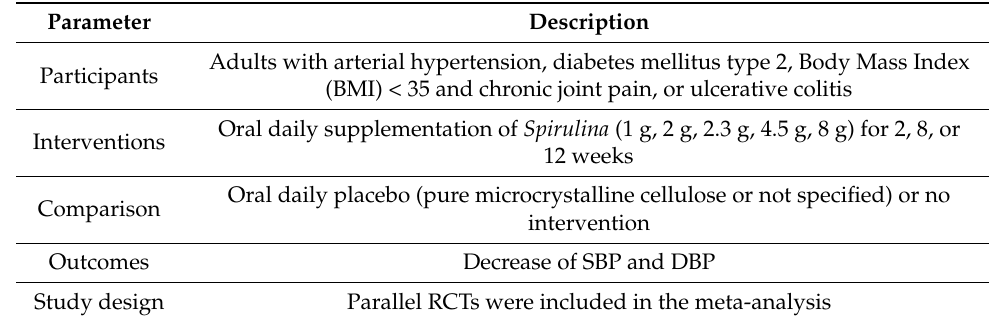
Table 2. Participants, Intervention, Comparison, Outcomes and Study design (PICOS) criteria for inclusion and exclusion of studies.